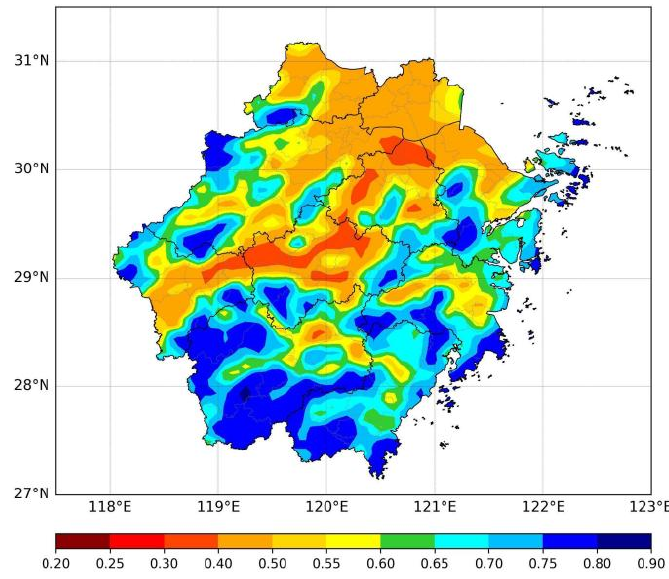
Figure 1. Distribution of SCI in Zhejiang Province.